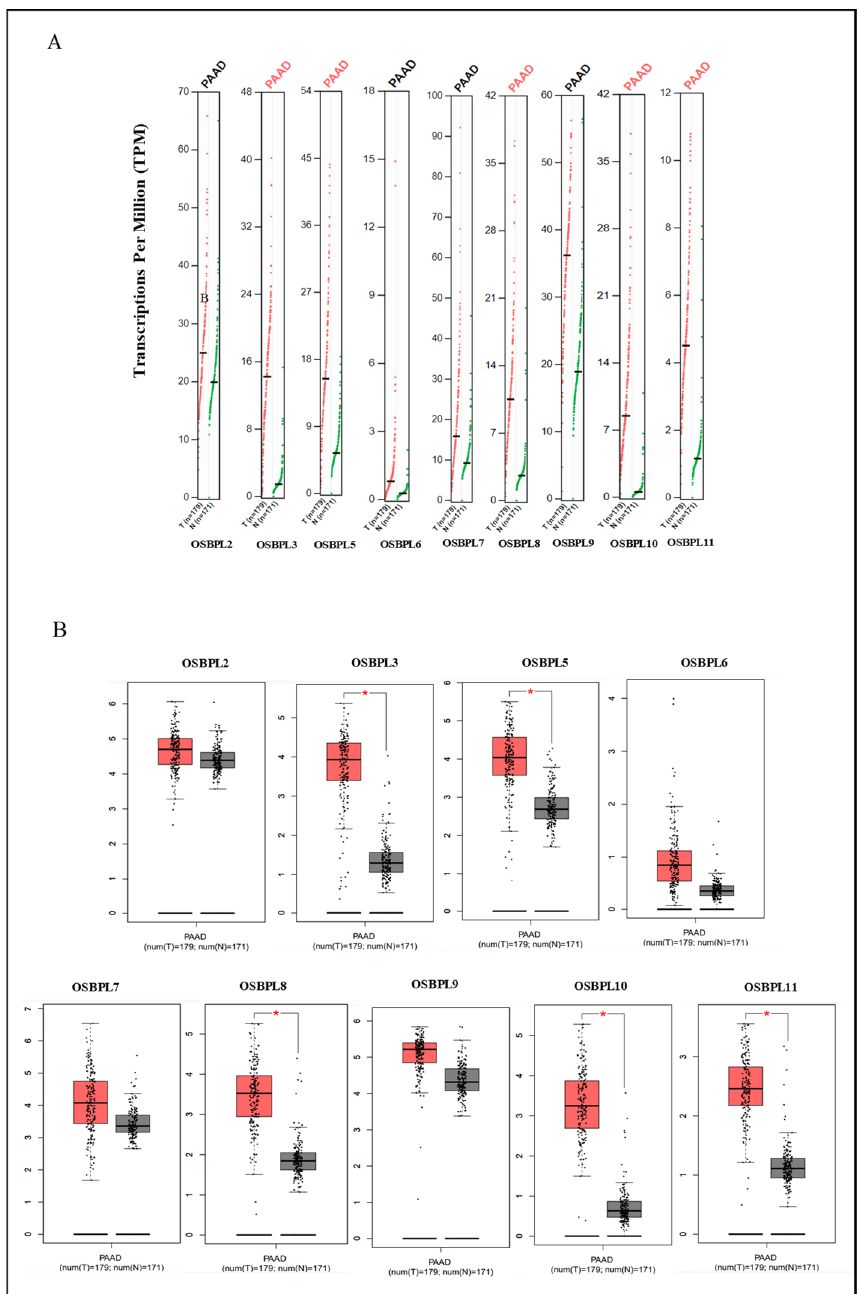
Figure 2. Transcription levels of oxysterol-binding protein (OSBP)-like (OSBPL) family members in pancreatic ductal adenocarcinoma (PDAC) patients. ( A ) Expressions of OSBPL members in PDAC) patients and normal tissue via the GEPIA 2 platform. The q-value cut-off was set to 0.01. ( B ) The red star in the pictures indicates a significant difference between PDAC and normal tissues; the p -value cut-off was set to 0.01 via the GEPIA 2 platform. PAAD in ( B ) is equal to PDAC. * p < 0.05